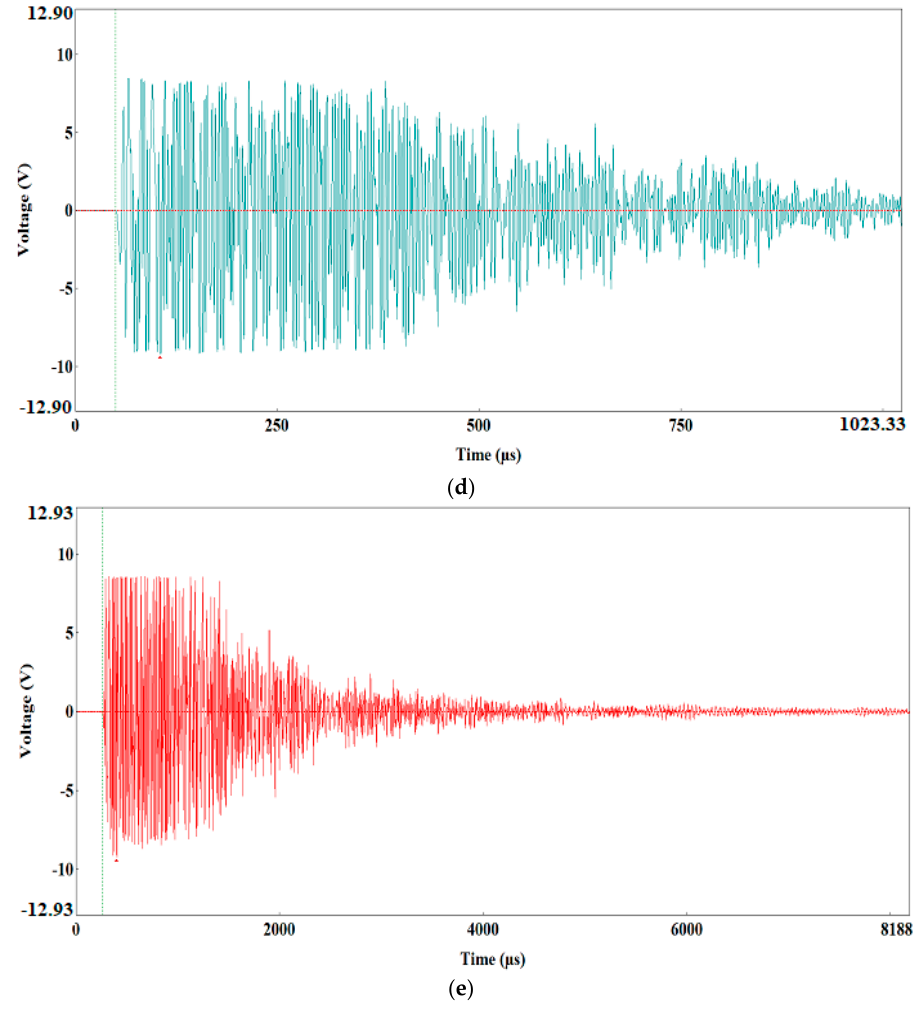
Figure 9. Waveform time domain charts for the individual classes of AE signals. ( a ) class 1; ( b ) class 2; ( c ) class 3; ( d ) class 4; ( e ) class 5.